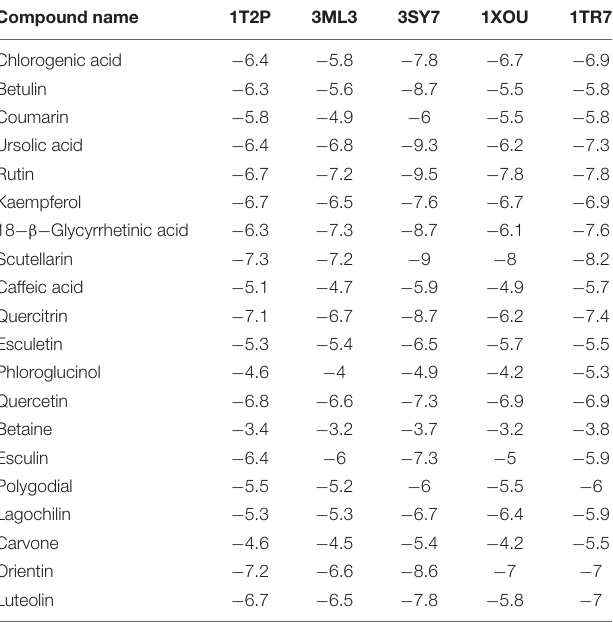
TABLE 5 | Binding affinities of top-rated pose of ligand–receptor